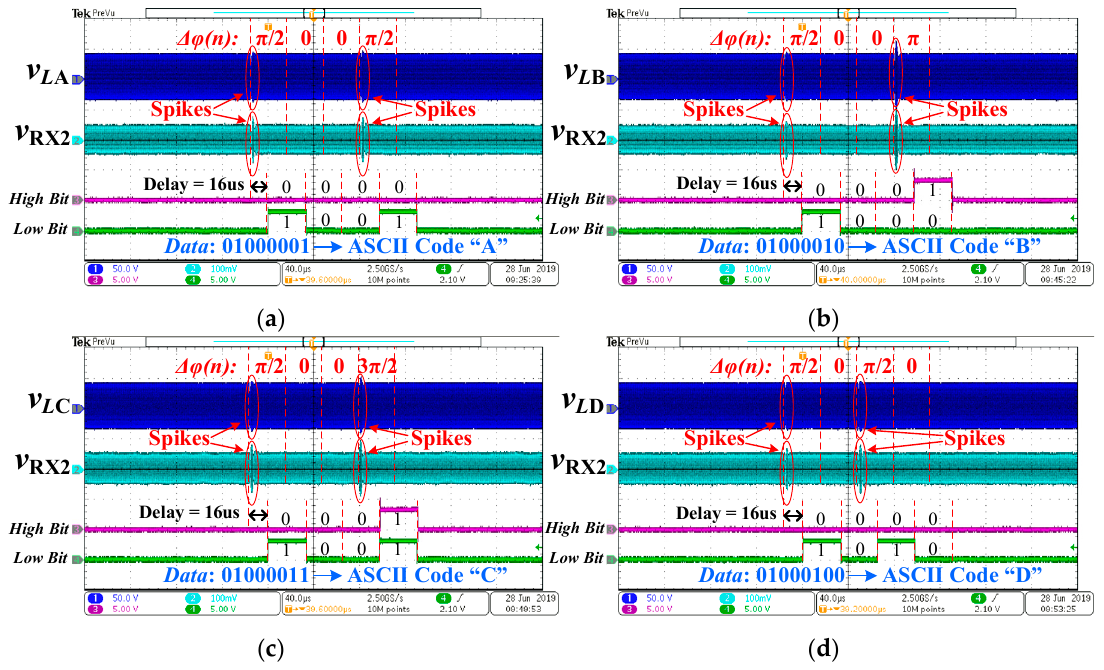
Figure 15. Identity (ID) detection waveforms of auxiliary signal coils: ( a ) L A ; ( b ) L B ; ( c ) L C ; and ( d ) L D . When the secondary power coil position was changed, the receiving voltage waveforms v RX2 were measured, as shown in Figure 16. In Figure 16a, the voltage amplitudes received from L A – L D are nearly equal when the secondary coil is aligned with the primary coil. This is because four signal coils are symmetric with respect to the secondary coil in this condition. In Figure 16b, the secondary coil was moved 100 mm along the x axis. The voltage amplitudes received from L B and L C are increased while the voltage amplitudes received from L A and L D are decreased. In Figure 16c, the secondary coil was moved 100 mm along the y axis. The voltage amplitudes received from L A and L B are increased while the voltage amplitudes received from L C and L D are decreased. In Figure 16d, the secondary coil was moved 50 mm along z axis. The voltage amplitudes received from L A – L D are nearly equal once again due to the symmetry. However, the receiving amplitudes in Figure 16d are smaller than those in Figure 16a because the effective mutual inductances between the auxiliary signal coils and the secondary power coil are reduced.